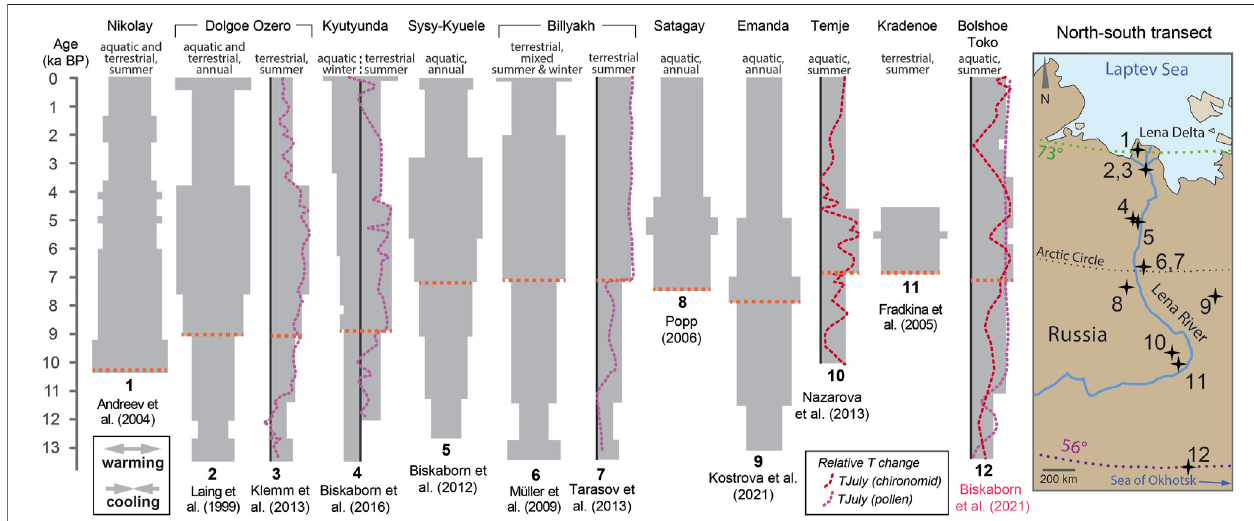
FIGURE9| SpatiotemporalvariabilityoftheHolocenethermalMaximum(HTM)inSiberiacompiledfrompaleolimnologicalstudies(Laingetal.,1999;Andreevetal., 2004; Fradkina et al., 2005; Popp, 2006; Müller et al., 2009; Biskaborn et al., 2012; Klemm et al., 2013; Nazarova et al., 2013; Tarasov et al., 2013; Biskaborn et al., 2016; Kostrova et al., 2021). Horizontal dashed orange lines indicate the onset of the HTM in each record. This graph was adopted from Biskaborn et al. (2016) and further developed in eastern and southern directions with two new sites.